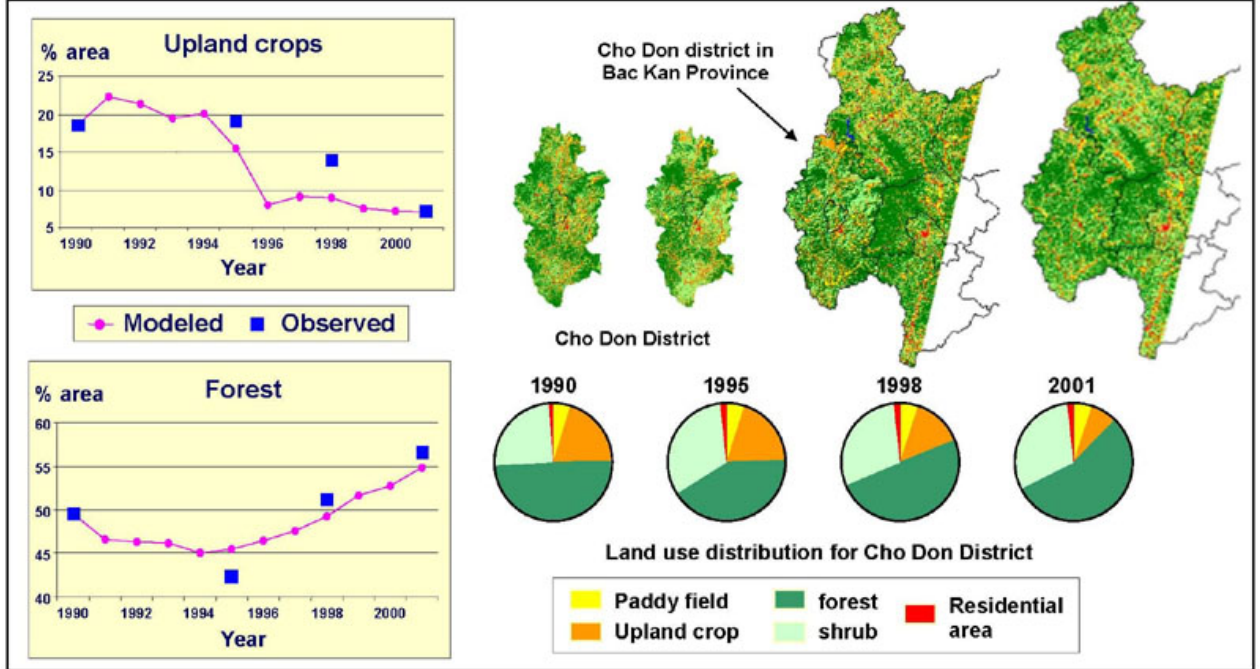
Fig. 9. Comparison of simulated maps and actual land use maps used to check the SAMBA-GIS